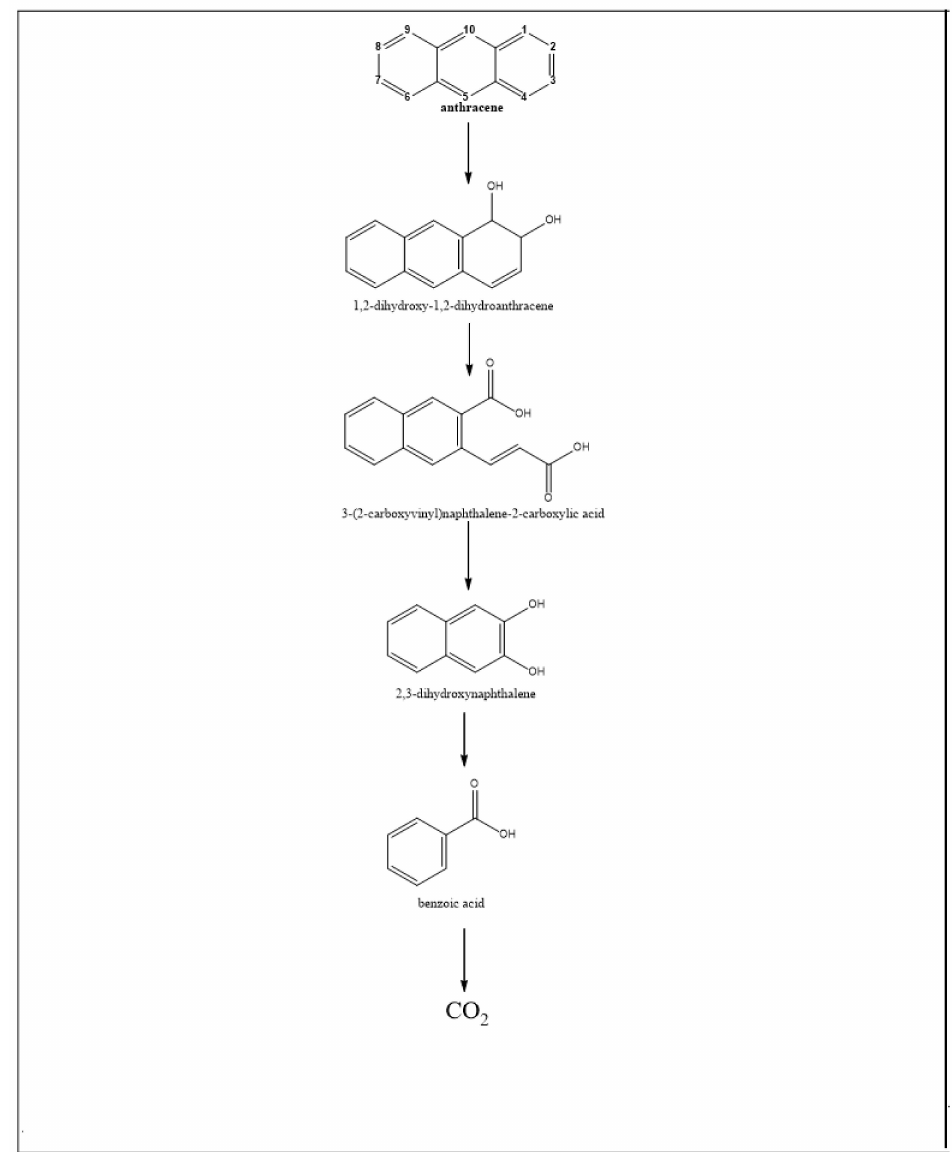
Figure 6. Biodegration pathways of anthracene in thermophilic bacteria. All these metabolites were identified from a strain of Nocardia otitidiscaviarum bacterium